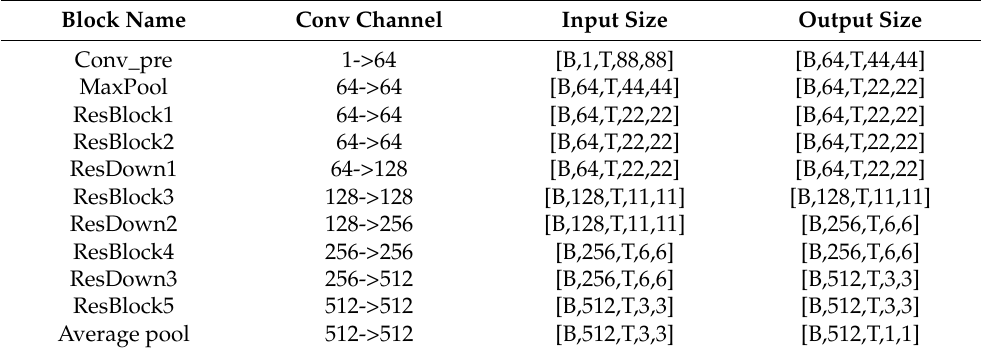
Table 1. 3D ResNet-18 network structure. The name of input and output parameters: batch size, channel, picture frame, height, and width.